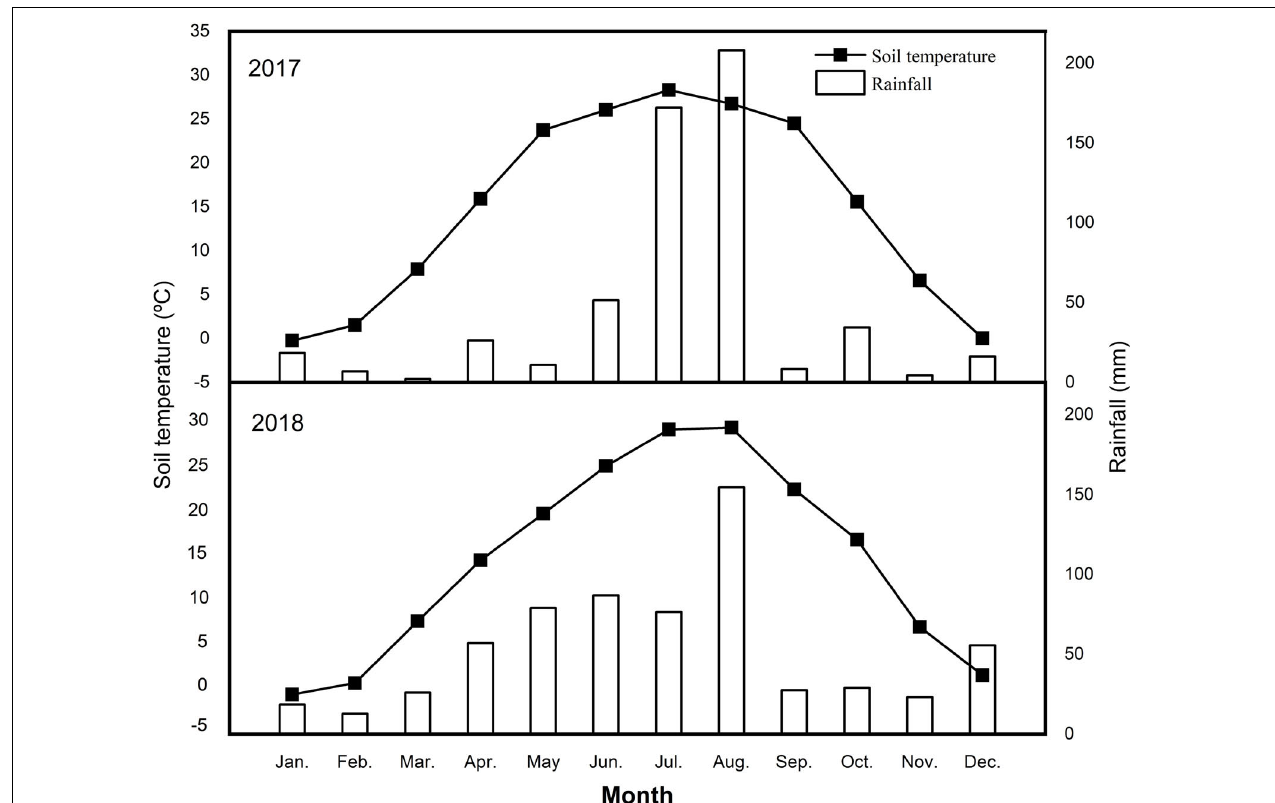
FIGURE 1 | Mean monthly rainfall and soil temperature at 5 cm depth in the years of 2017 and 2018.